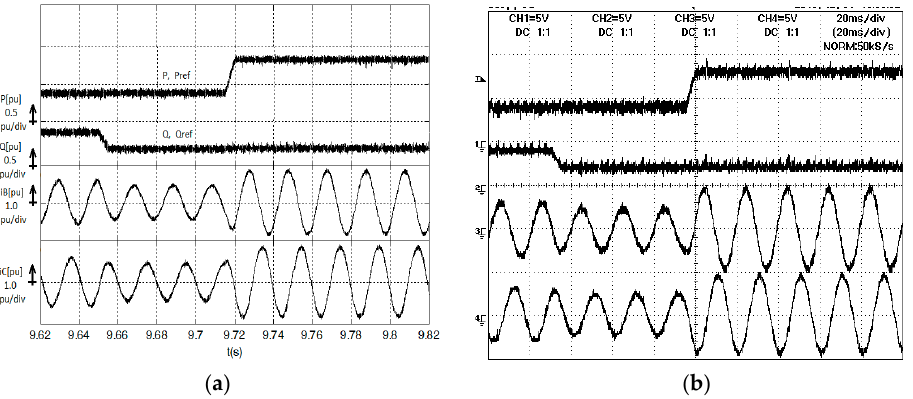
Figure 8. Active and reactive power response and line currents for a P and Q step Δ P Ref = +0.4 pu and Δ Q Ref = +0.2 pu). ( a ) Simulation Results; ( b ) Experimental results, Ch1 = Ch2 = 0.5 pu/div ( P Series and Q Series) and Ch3 = Ch4 = 1.0 pu/div (iB and iC).